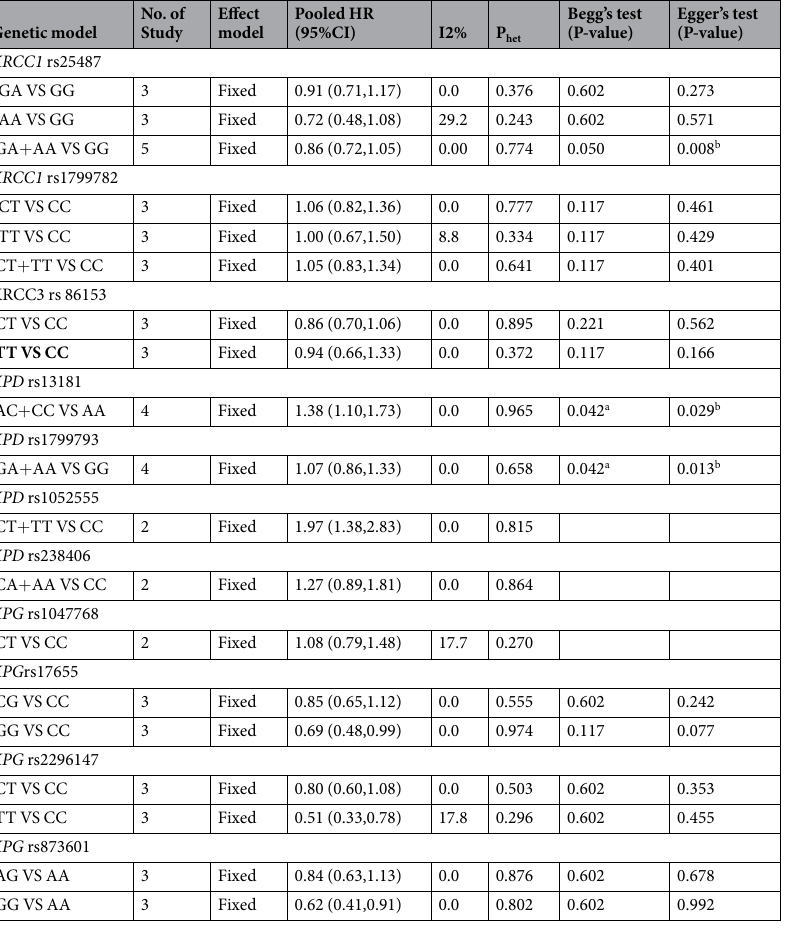
Table 4. The association between candidate gene polymorphisms and PFS. a Begg’s test P < 0.05; b Egger’s test P <